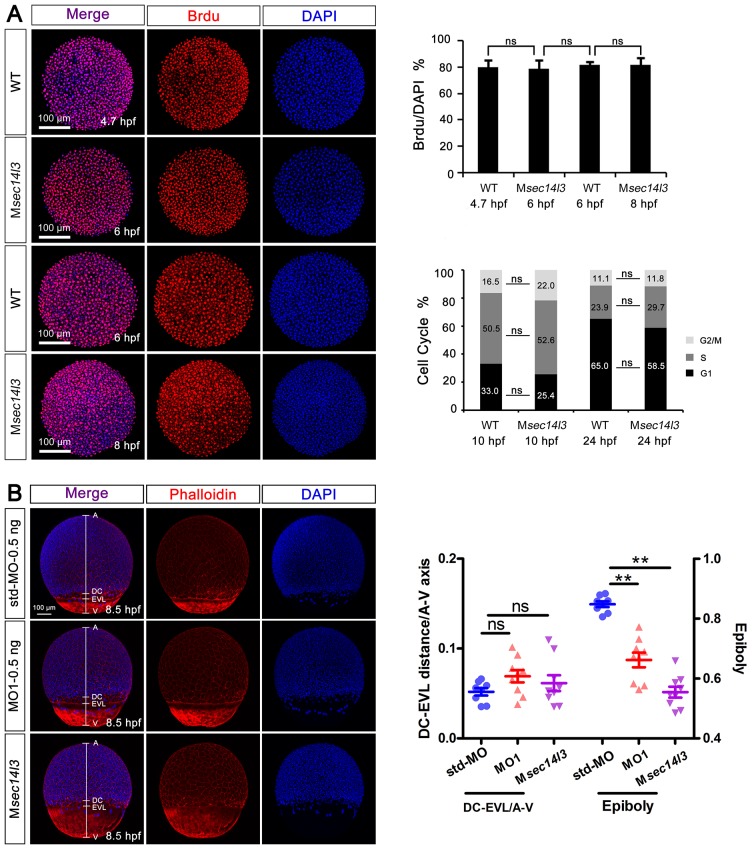
Sec14l3 depletion has no effect on cell proliferation or cell cycle progression, as well as cell adhesion between envelop layer (EVL) and deep cells (DC).(A) Cell proliferation analysis based on Brdu incorporation and cell cycle progression analyzed by flow cytometry were performed. The ratios of Brdu/DAPI indicating percentages of proliferating cells are shown at the right top; Right bottom panel shows the result of cell cycle analysis, and the percentages of individual phases are labeled. Light grey indicates G2/M phase, grey indicates S phase and black indicates G1 phase. No evident difference is observed between control and mutant embryos. Data are presented as mean ± SEM. Significance was analyzed using Student’s t-test (ns, non-significant). scale bars, 100 μm. (B) Distance measurement between envelop layer (EVL) and deep cells (DC) based on phalloidin (red) and DAPI (blue) staining, see also in Figure 1—source data 1. The left panel shows immunostaining results in sec14l3 morphants and Msec14l3 mutants at 8.5 hpf. Embryos were laterally viewed with animal pole (A) to the top, vegetal pole (V) to the bottom and the marginal borders of DC and EVL are marked. Statistical results of 10 embryos from each group are shown at the right panel. Ratios of DC-EVL distance to A-V axis and epiboly are calculated.